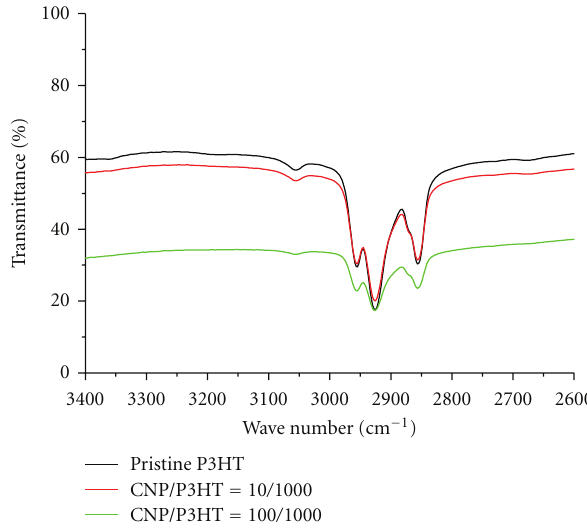
Figure 6: FTIR image of pristine CNP/P3HT and di ff erent CNP